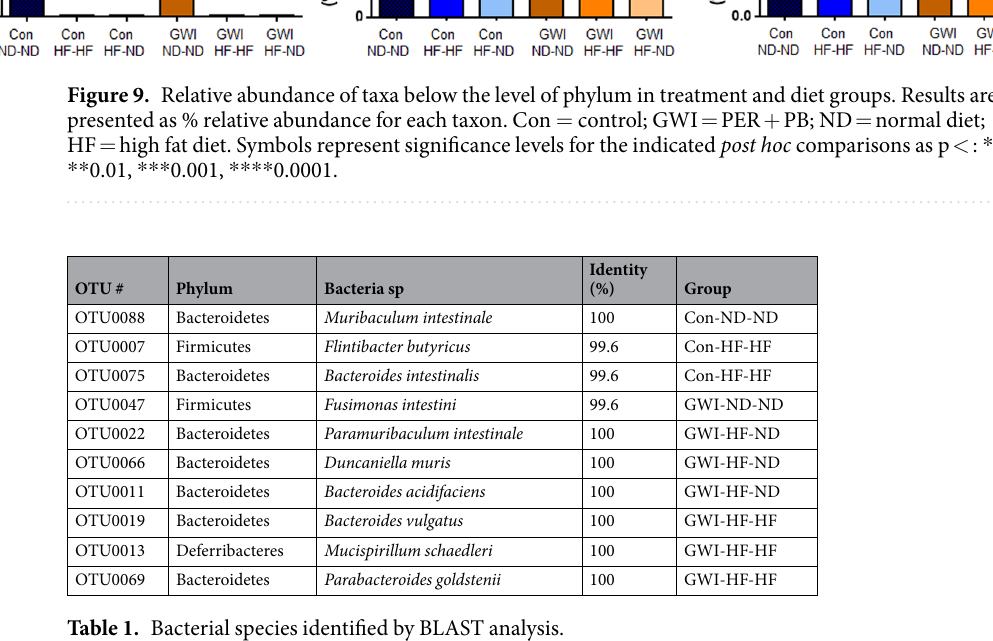
Table 1. Bacterial species identified by BLAST